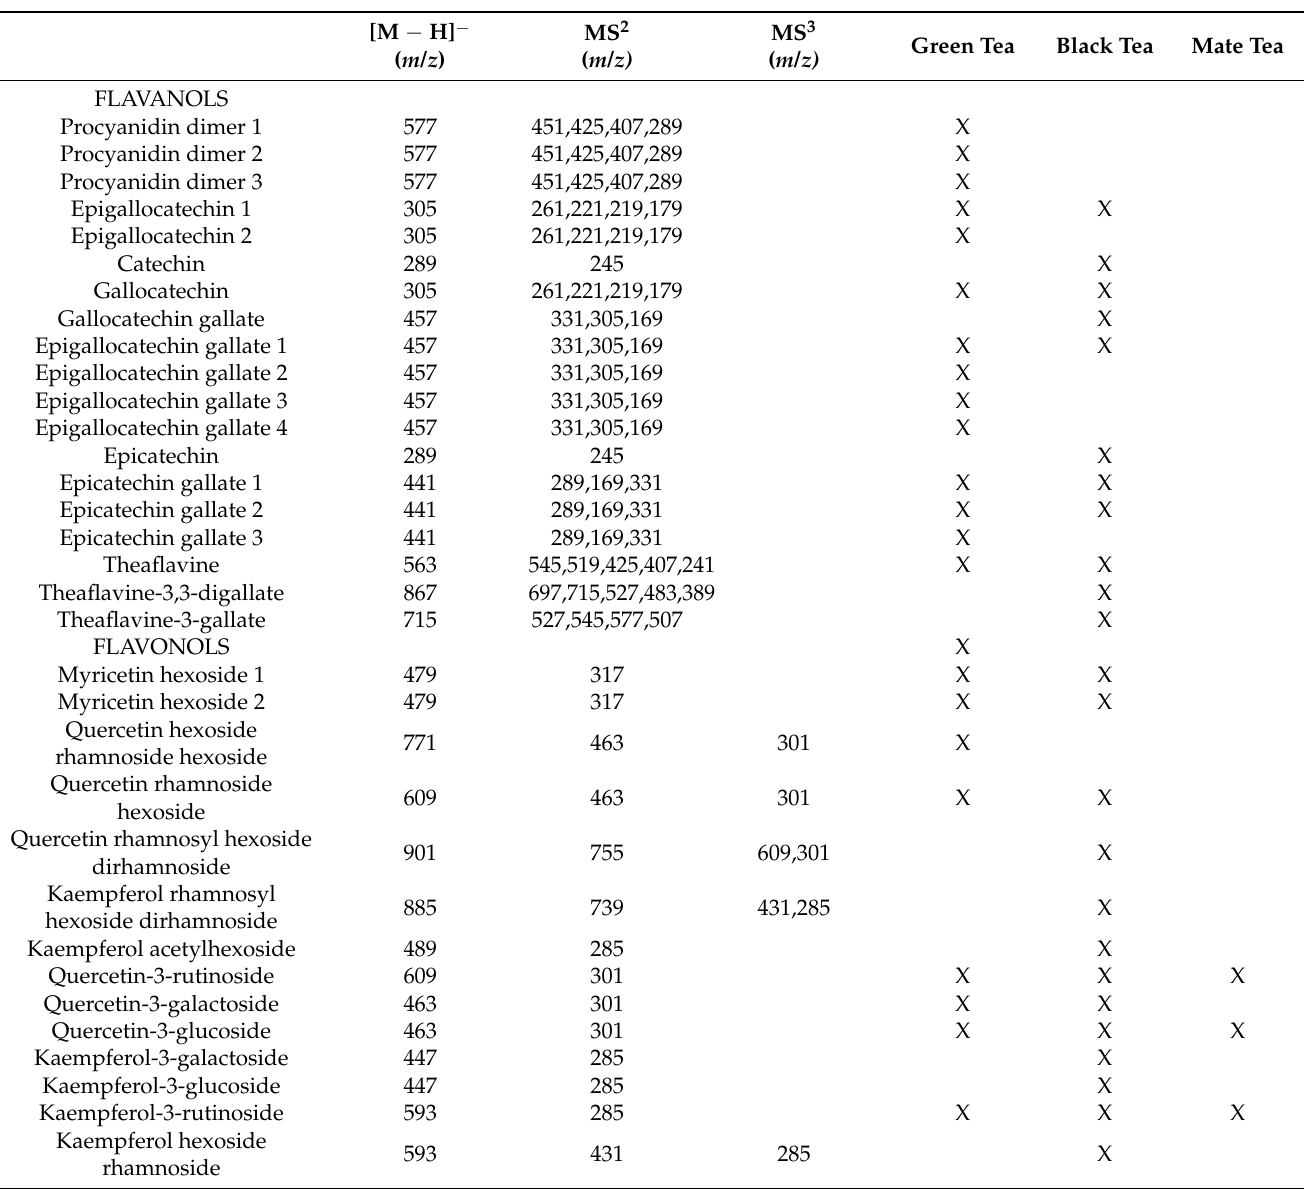
Table 1. Identification of phenolic compounds in green, black, and mate tea in negative ionization with HPLC-MS and MS 2 /MS 3